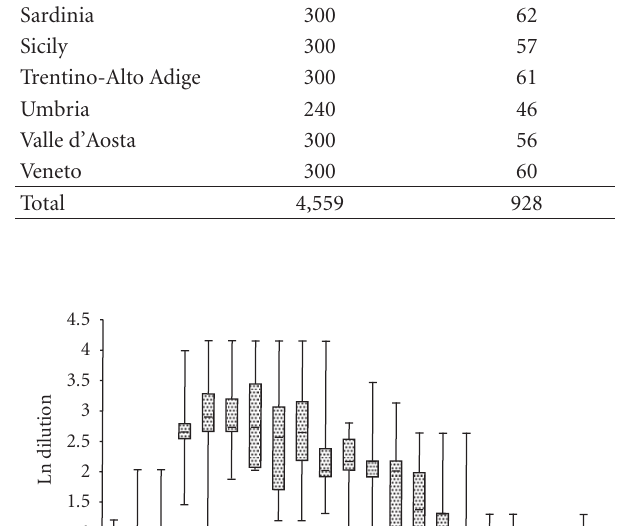
Figure 2: Median, maximum value, minimum value, 25th per- centile, and 75th percentile of RB51-CFT results in control animals ( n =